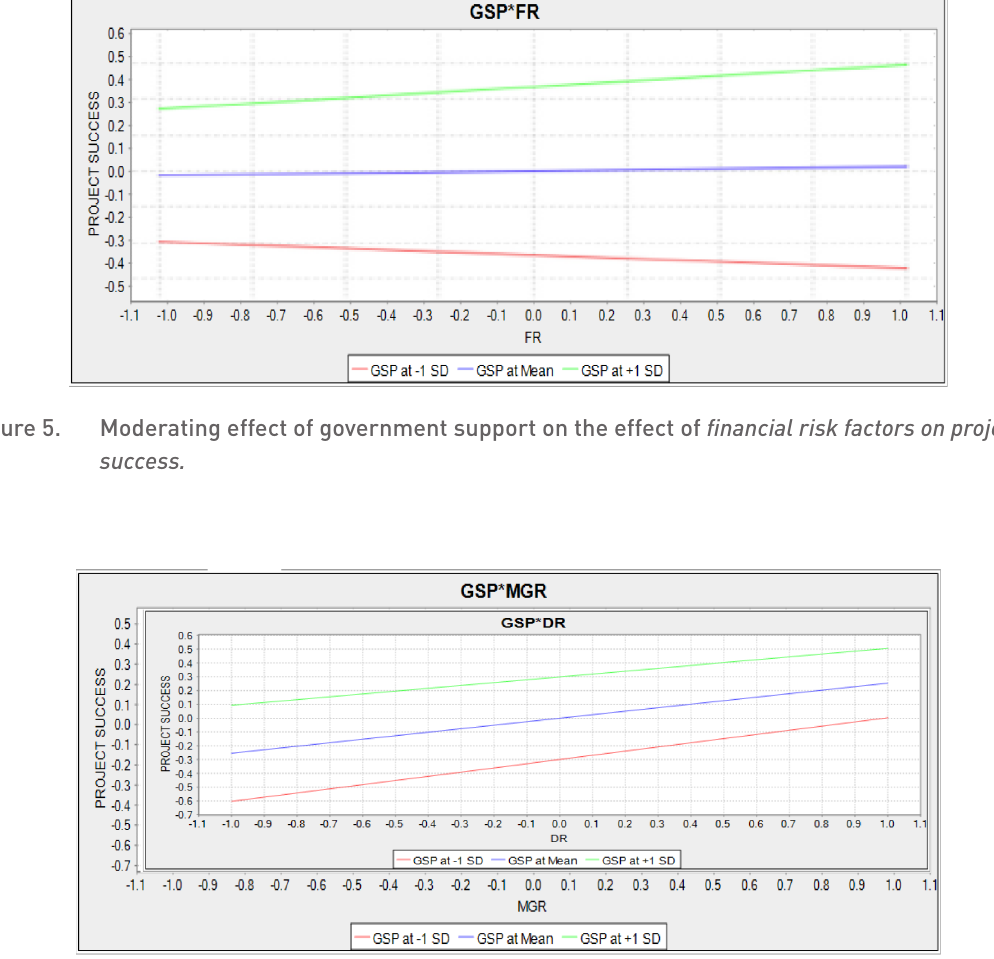
Figure 6. Moderating effect of government support on the effect of management risk factors on project success.